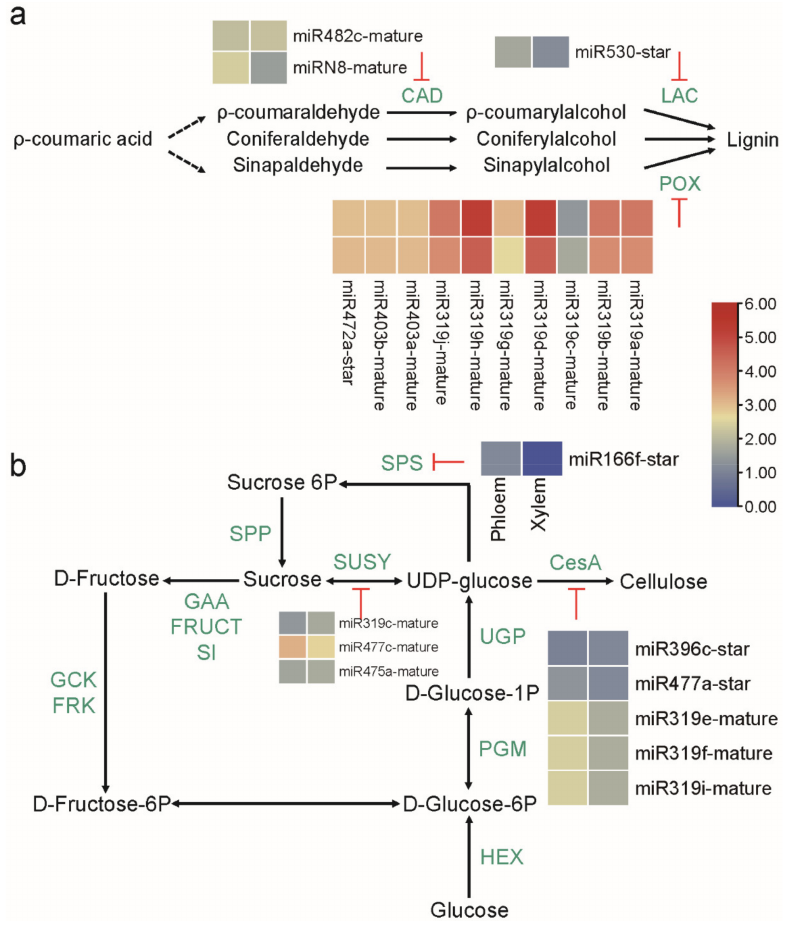
Figure 4. Typical pathways of lignin ( a ) and cellulose ( b ) biosynthesis in P. deltoides . Intermediates are shown in black, and the enzymes involved in each step are shown in green. The “T” arrows indicate the enzymes that could be cleaved by miRNAs supported by the degradome; expression levels was log10 ( RPTM + 1)